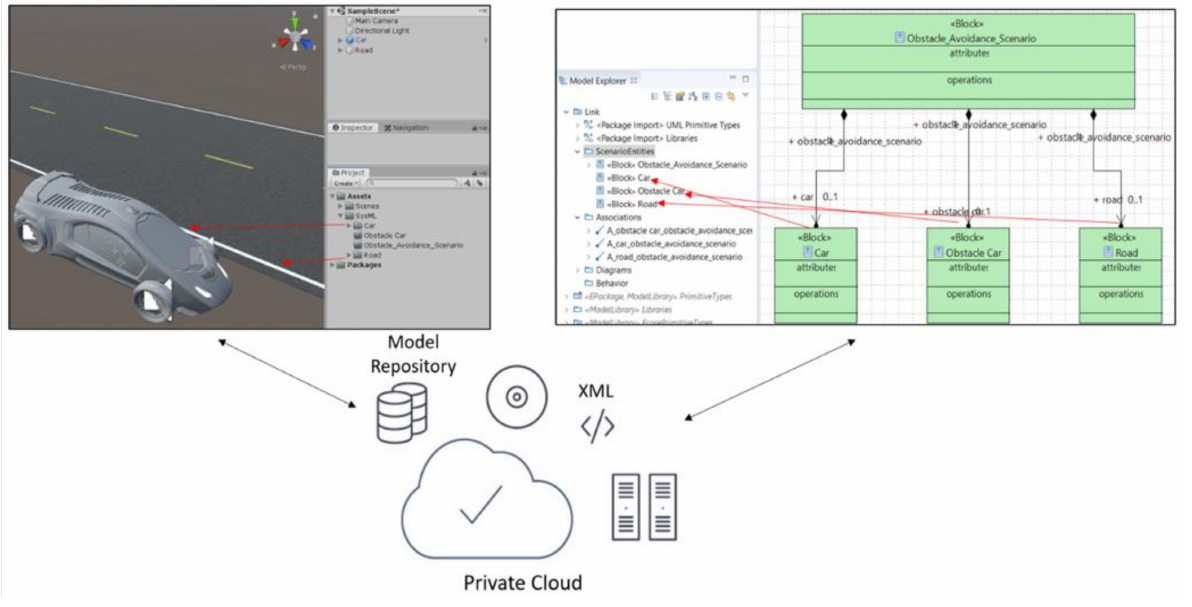
Figure 13. SysML to 3D virtual simulation mapping.